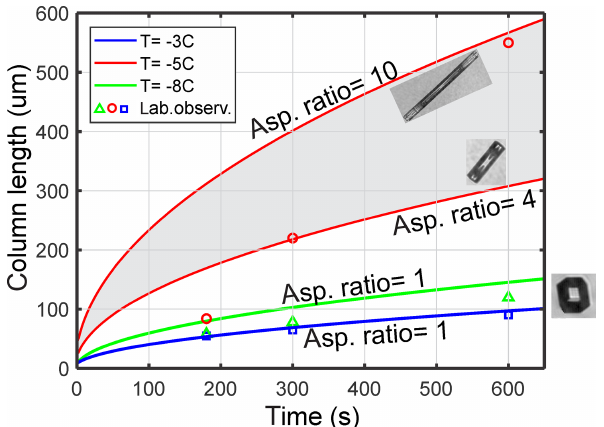
Figure 2. Calculated ice column growth at vapor saturation over water at − 3, − 5, and − 8 ◦ C. Triangles, circles, and squares are lab- oratory observations by Fukuta and Takahashi